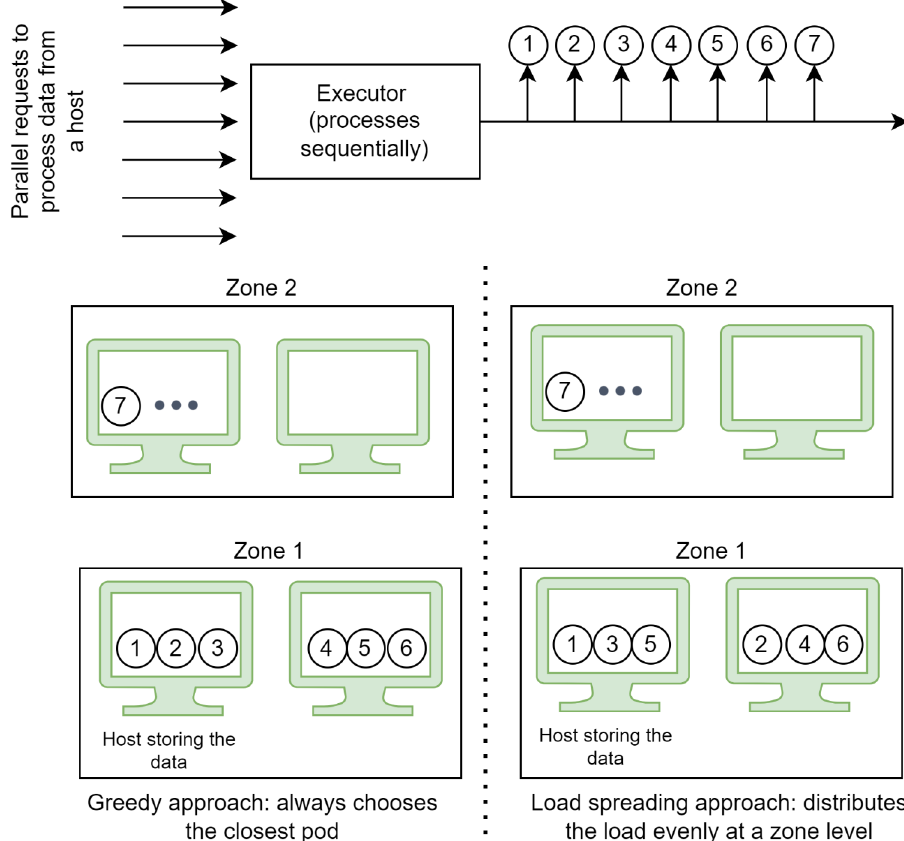
Figure 5. Routing priority for the greedy and load spreading